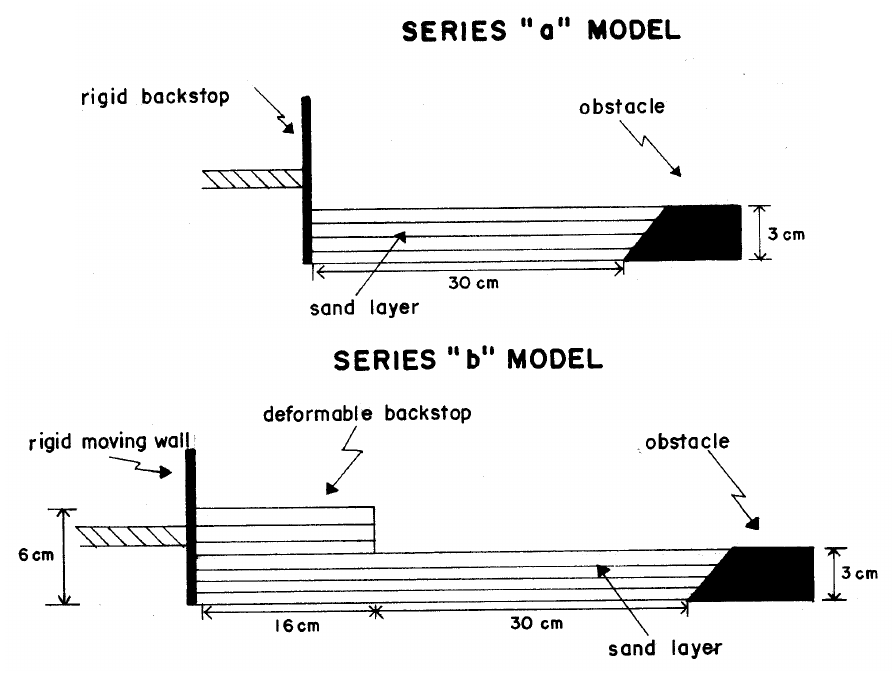
Fig. 4 – Sketches of the experimental boxes (models M2), illustrating the boundary conditions of series “a” and series “b”